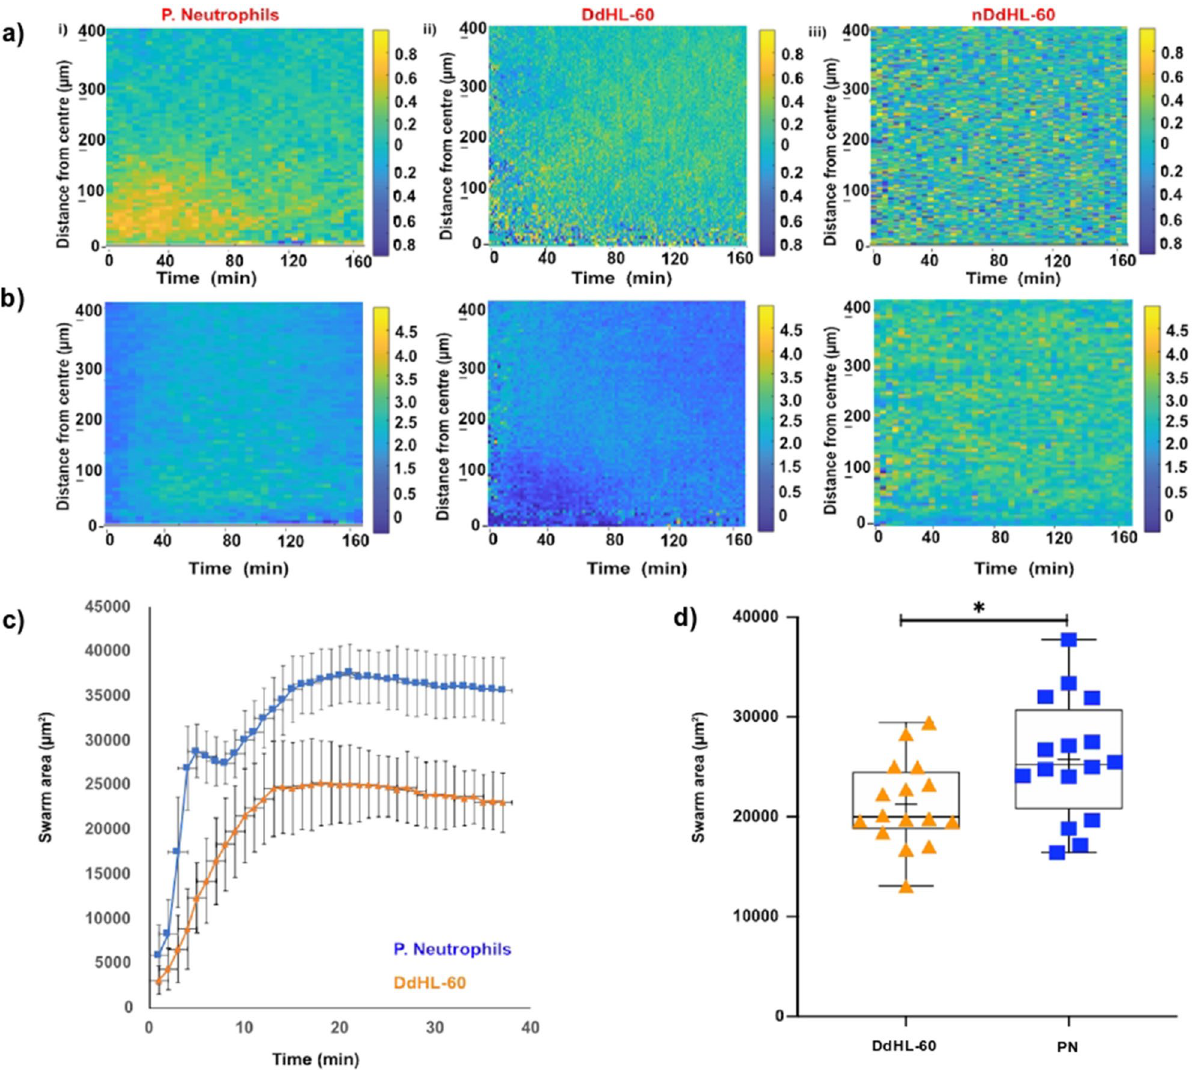
Figure 6. Quantification of primary neutrophil and HL-60 swarming. ( a ) Chemotactic index (CI) and speed over time, towards zymosan particle clusters in (i) primary neutrophils, (ii) DdHL-60, (iii) nDdHL-60. ( b ) The speed of migration increases with time towards zymosan particle clusters (scale bar: CI above 0.8 indicates the cells that are chemotaxing toward zymosan particle. speed (µm/min) = 4.5 means cell moving toward zymosan particle). ( c ) Primary neutrophils (blue curve) accumulation on targets is fast and form a bigger swarm and dHL-60 neutrophil (orange curve) aggregation proceeds fast and then continues slower over time. ( d ) Comparison of area of swarm formed between primary neutrophils (PN) and dHL-60 (HL-60). Comparison were performed by unpaired, two-tailed t-test; * P < 0.05). Error bars represent standard deviations for these measurements. Figure 5 shows representative image of experiment of N = 30 swarm